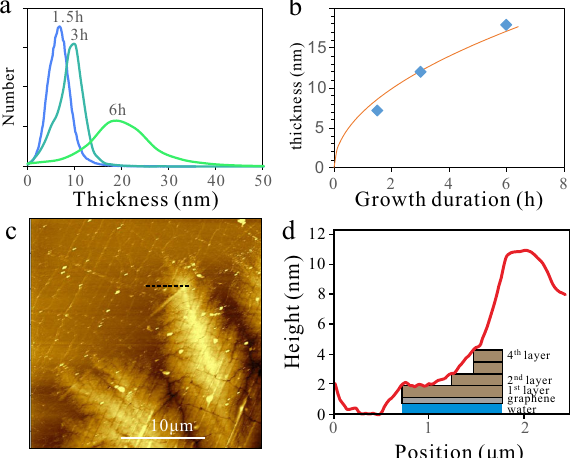
Fig. 3 Thickness control towards single TMMC layers. a Histogram plot of height distribution vs. occurrences for Cu 2 S crystals obtained after different growth durations, b fi t of time evolution of average thickness to diffusion model described in the text, c AFM image of ultrathin CuSe, d cross-sectional height distribution indicated in c and schematic of layer morphology (with graphene and water being drawn as lowest layers for convenience).